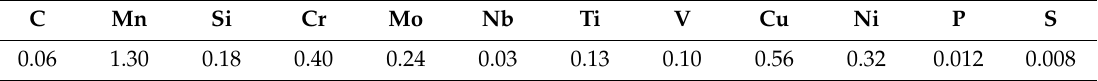
Table 1. The chemical composition of the experimental steel